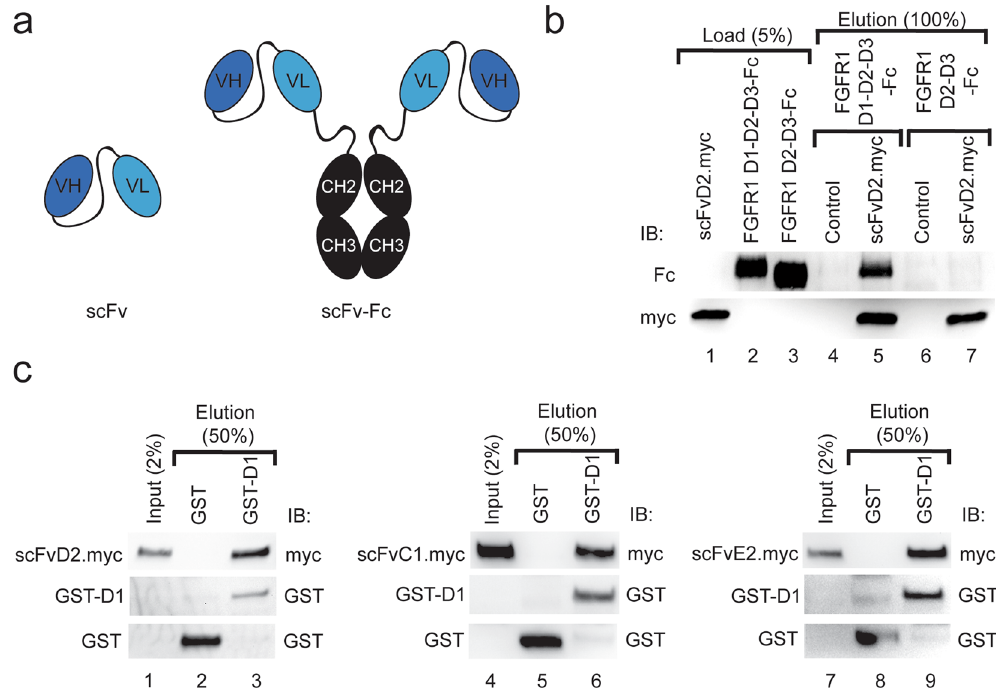
Figure 1. Antibody fragments bind to the domain D1 of FGFR1. ( a ) Schematic representation of anti-FGFR1 antibody fragments used in this study. The scFv antibody format contains single antigen binding site formed by variable domains of heavy and light antibody chains (VH and VL), whereas scFv-Fc antibody fragments contain two identical binding sites for antigen fused by constant domains of heavy chain of human IgG1 (CH2 and CH3). ( b ) Analyzed antibodies recognize epitopes within domain D1 of FGFR1. scFvD2.myc was bound to the anti-c-Myc agarose and incubated with either purified full length extracellular part of FGFR1 fused with Fc fragment (FGFR1 D1-D2-D3-Fc) or with the Fc-fusion of the extracellular part of FGFR1 lacking domain D1 (FGFR1 D2-D3-Fc). Proteins bound to scFvD2.myc were analyzed with anti-Fc antibodies. ( c ) Direct Interaction of scFv’s with the domain D1 of the FGFR1. Recombinant GST (Control) and GST-tagged domain D1 of the FGFR1 (GST-D1) were bound to Glutathione Sepharose and incubated with scFv proteins. Proteins bound to GST and GST-D1 were eluted and analyzed by Western blotting using specific antibodies. Cropped blots were displayed, full size blots are included in Supplementary